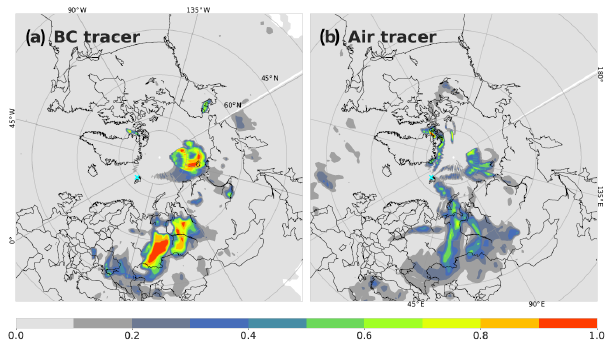
Figure 6. Potential source contribution areas for BC observations at Zeppelin Station, Svalbard. The color scale represents statistical potential (1 : 100%) for the 80th percentile of observed values to originate from certain areas of the Northern Hemisphere. (a, b) The air mass transport calculations using the FLEXPART model with the BC tracer and air tracer,